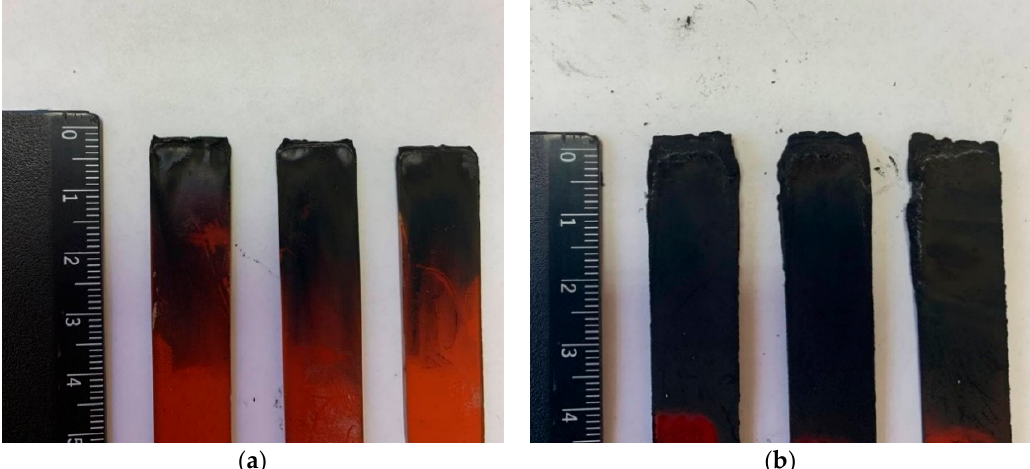
Polymers 2021 , 13 , x FOR PEER REVIEW Figure 12. Photos of the tested samples of polyP-q ( a ) and polyP-d ( b ). Figure 12. Photos of the tested samples of polyP-q ( a ) and polyP-d ( b ).